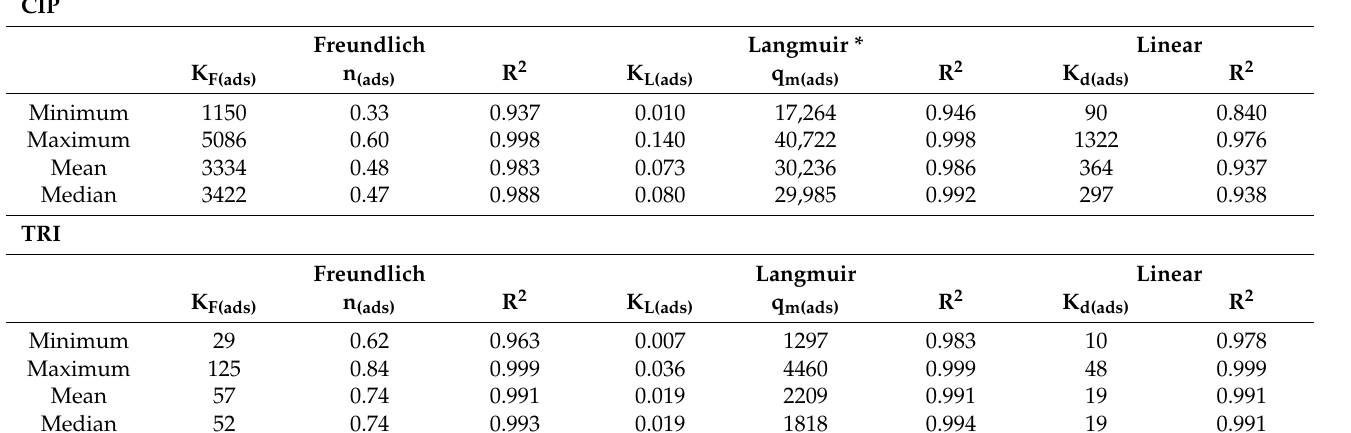
Table 3. Minimum, maximum, mean and median of the parameters resulting from the fits of the experimental adsorption data to the Freundlich, Langmuir and linear models, for ciprofloxacin (CIP) and trimethoprim (TRI). K F (L n µ mol 1 − n kg − 1 ) is the Freundlich affinity coefficient; n